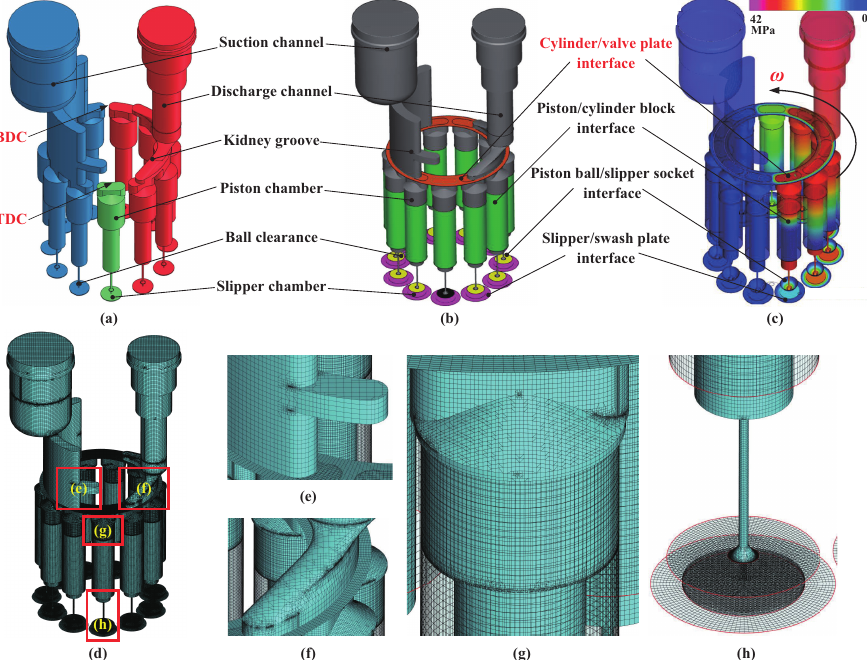
Figure 9. Full oil film CFD model of the APP. ( a ) Fluid domain. ( b ) Mesh division. ( c ) Pressure clouds. ( d ) Overall mesh diagram. ( e ) Suction channel. ( f ) Discharge channel. ( g ) Piston chamber. ( h ) Ball clearance and slipper